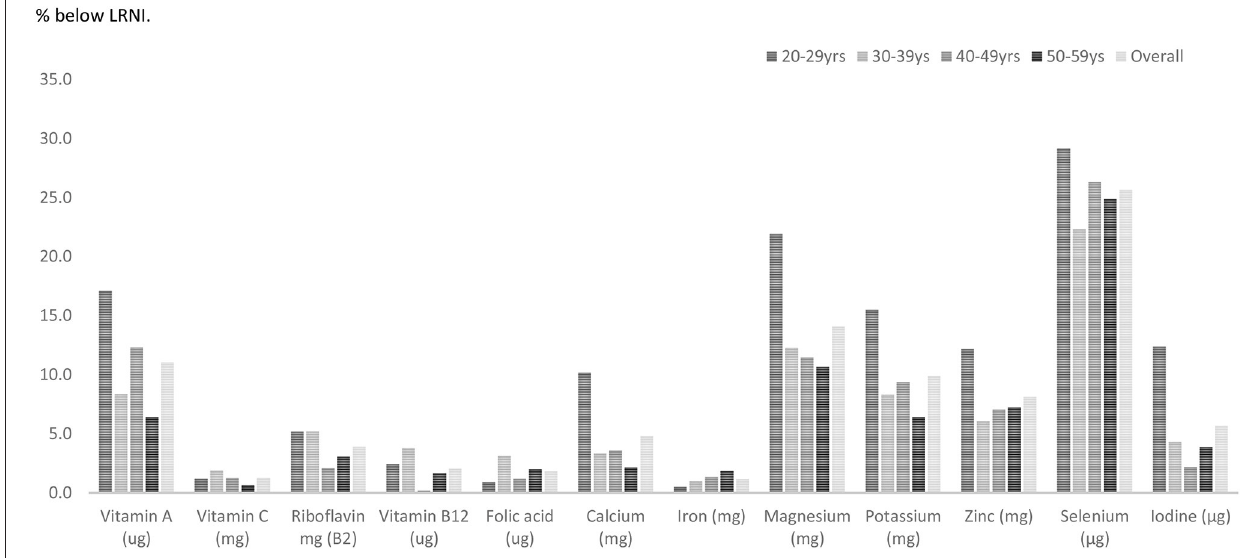
FIGURE 3 | Percentage of males with vitamin and mineral intakes below the LRNI across mid-life.